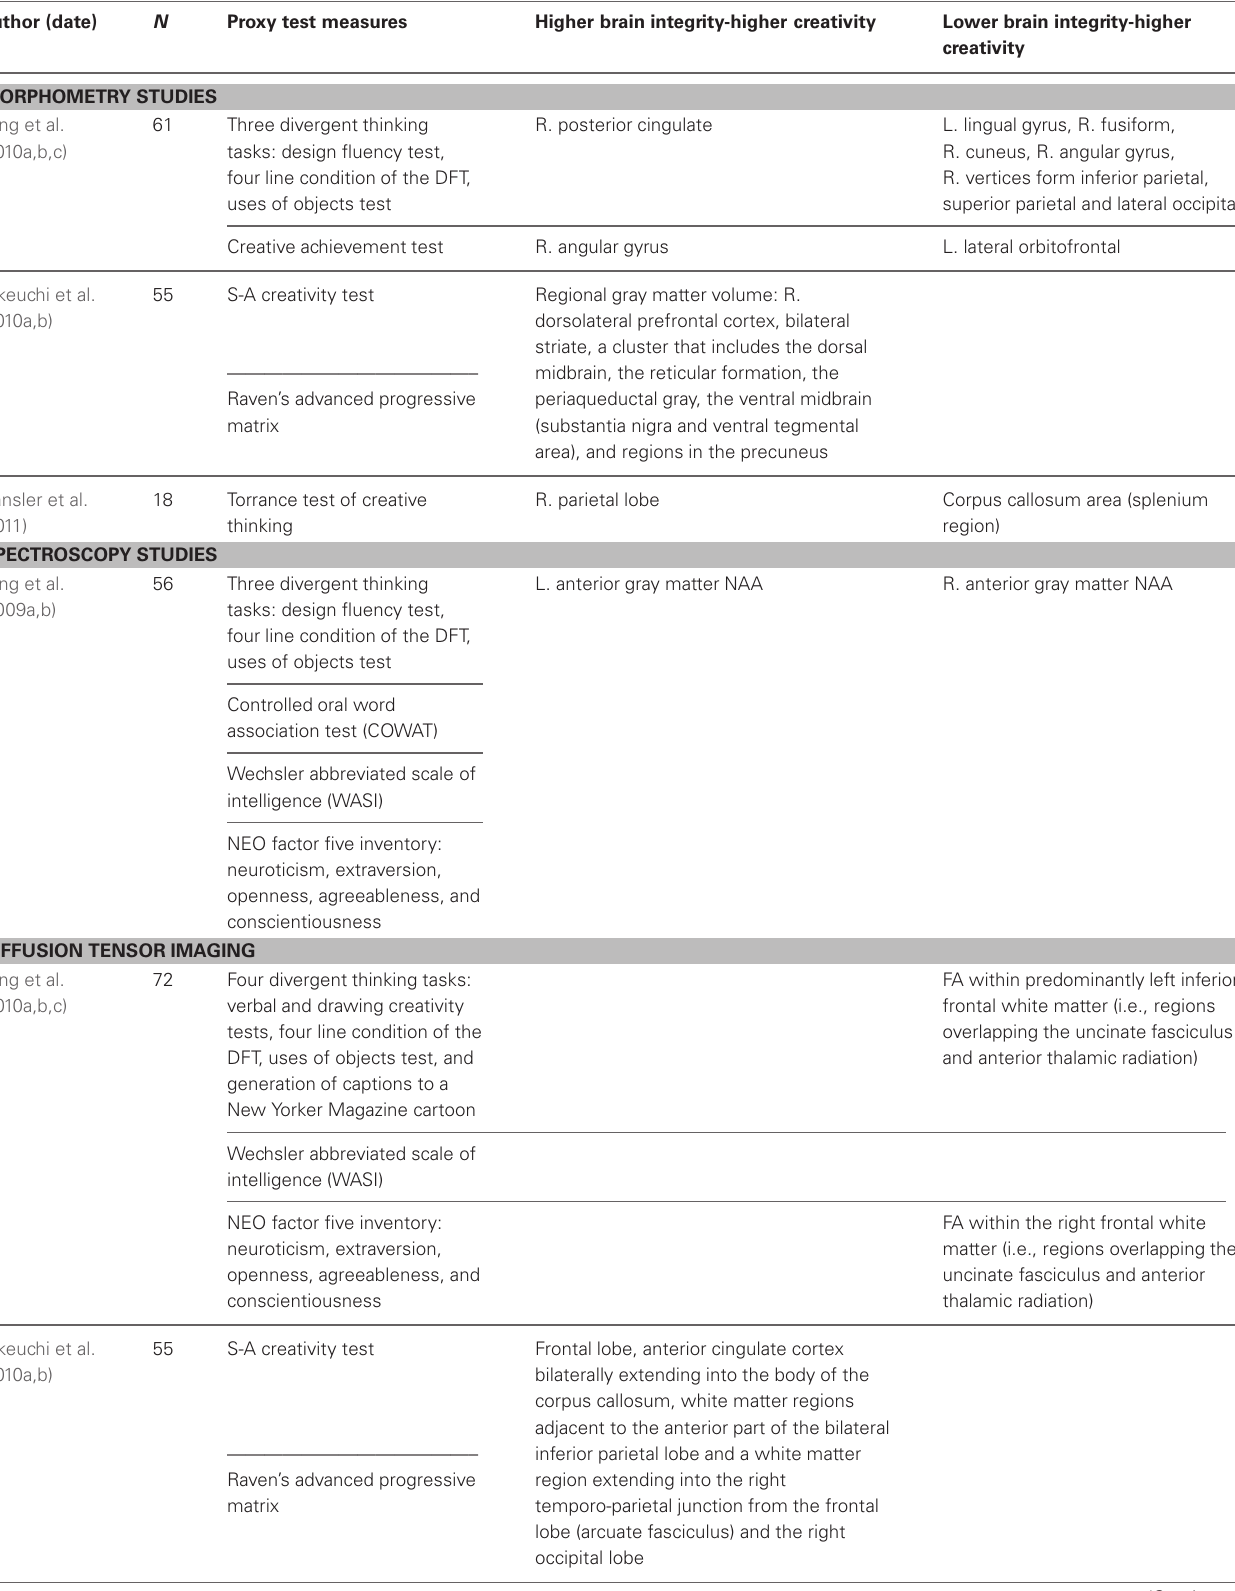
Table 1 | Structural studies